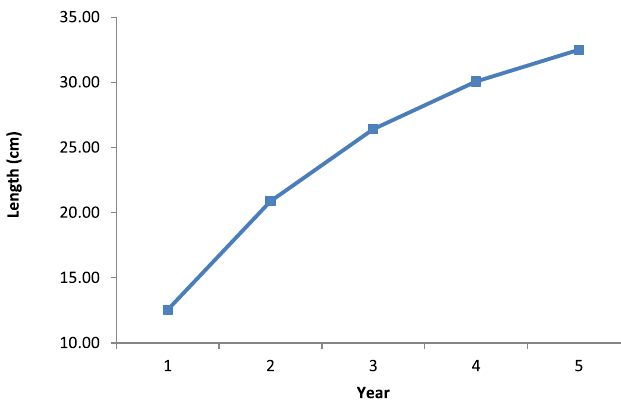
Fig. 4. Growth of S. undosquamis from southeastern Arabian Sea during different years.